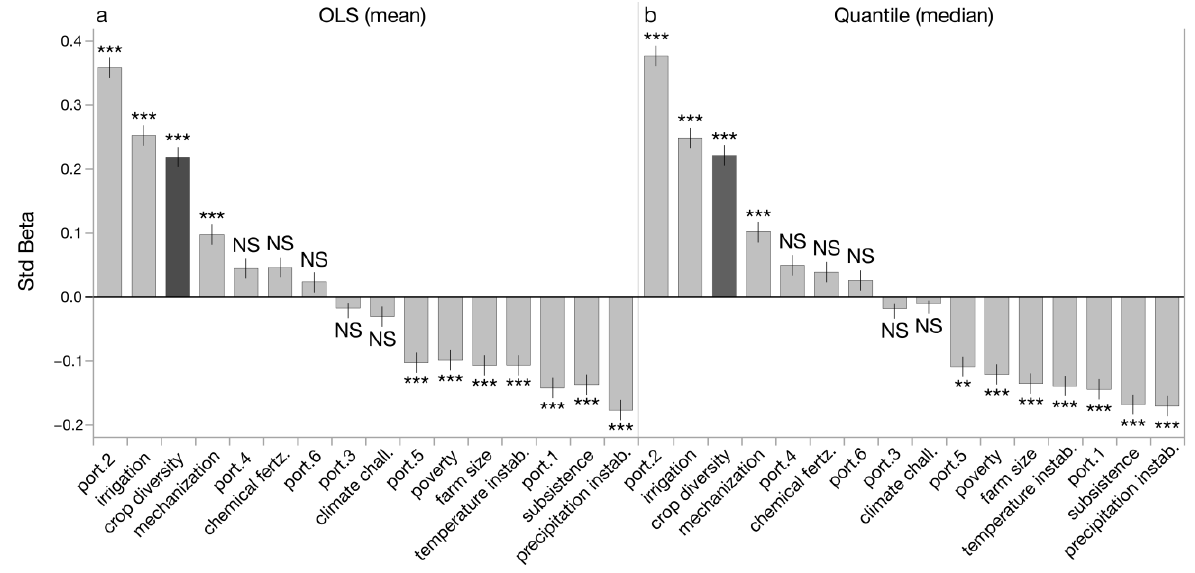
Figure 4. Results of Model 3 showing standardized effects of crop diversity (shaded dark) and other predictors (shaded gray) on crop revenue stability (relative) in southern Mexico for ( a ) standard ordinary least squares (OLS) and ( b ) quantile (median) regressions. All continuous variables were transformed and standardized (z-scored) to meet model assumptions and to facilitate comparison of results (for transformation details, see end of Section 2.5). The categorical predictor, crop portfolios, included seven levels. Analysis used effect coding with Portfolio 7 as the reference level. ** p < 0.01, *** p < 0.001, NS = not statistically significant.